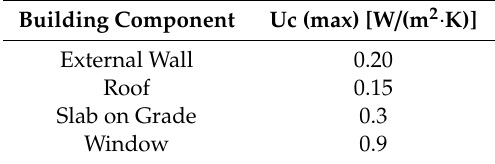
Table 2. External wall, roof, and ground floor maximum U-values according to building regulations in force in Poland